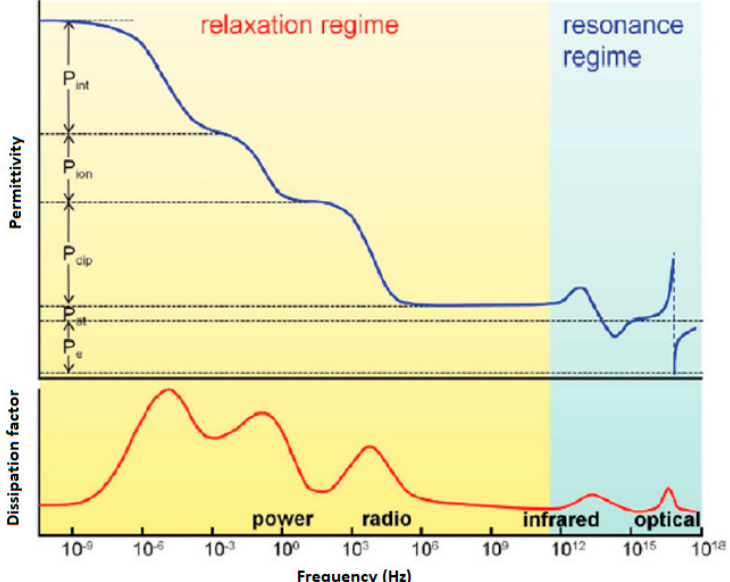
Figure 1. Types of polarization versus frequency in polymers. P e : electronic polarization; P at : atomic polarization; P dip : (dipolar) orientational polarization; P ion : ionic polarization and P int : interfacial polarization. The top panel shows the real part of the dielectric constant ( ε ’), and the bottom panel shows the imaginary component of the dielectric constant (dissipation factor, ε ”). Reprinted with permission from reference [7]. Copyright 2012, American Chemical Society.